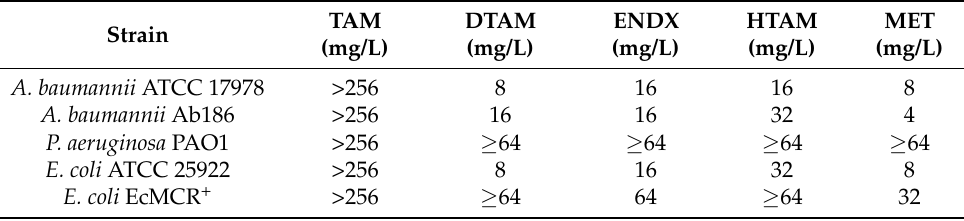
Table 2. Minimal inhibitory concentrations of tamoxifen and its metabolites for A. baumannii ATCC 17978, P. aeruginosa PAO1, and E. coli ATCC 25922 strains. TAM DTAM Strain (mg/L) (mg/L)